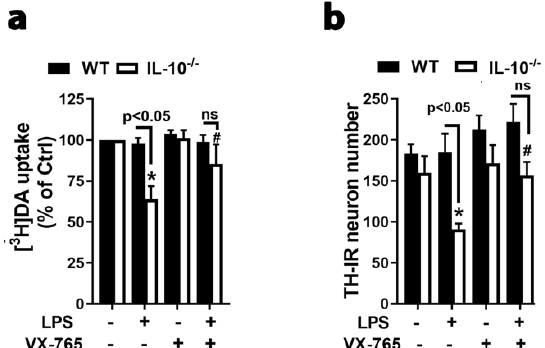
Figure 5. Inhibition of caspase-1 attenuated LPS-induced damages of dopamine (DA) neurons. ( a , b ) [ 3 H]DA uptake assay ( a ) and counting of TH-IR DA neurons ( b ) conducted 7 d after LPS treatment showed dopaminergic neuroprotection by post treatment with 10 µ M VX-765 with a 9 h delay in midbrain neuron-glia cultures generated from IL-10 − / − mice. Results are the mean ± SEM of 4 independent experiments. Significance was determined by two-way ANOVA with Tukey’s multiple comparisons ( a ) or student t -test ( b ). * p < 0.05 as compared with the corresponding saline-treated control cultures and # p < 0.05 as compared with the corresponding LPS-treated cultures. ns, not significant.